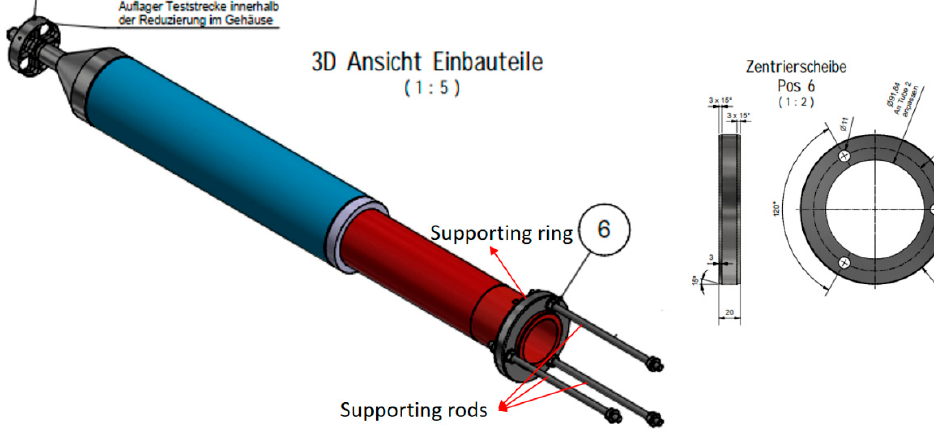
Figure 15. Supporting ring and rods.